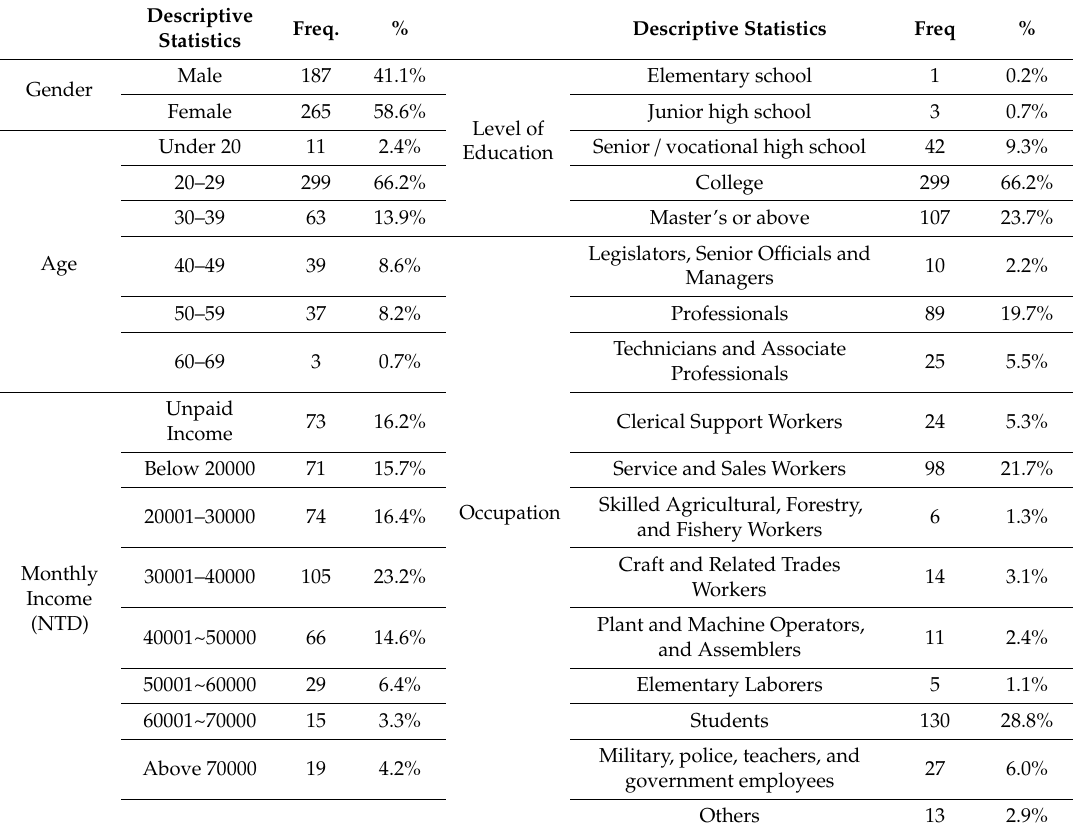
Table 1. Descriptive statistical